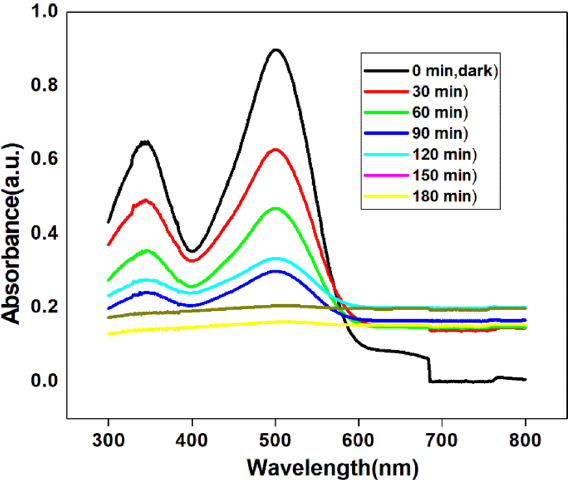
Figure 15. Absorbance spectrum of photo degradation of Congo red dye solution by NT1 (initial concentration = 20 µM, Catalyst dosage = 0.5 g l −1 , pH = 4).